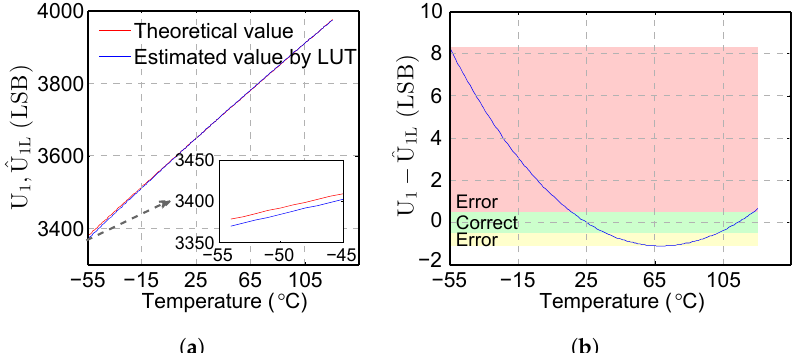
Figure 3. ( a ) Theoretical U 1 and computed value of ˆU 1L by the LUT method; ( b ) estimation deviation of the LUT method ∆ U 1L = U 1 − ˆU 1L . The deviation ∆ U 1L ≥ 0.5 LSB (red area) and ∆ U 1L ≤ − 0.5 LSB (yellow area) result in an incorrect voltage estimation. The LUT method shows a large estimation deviation at a low